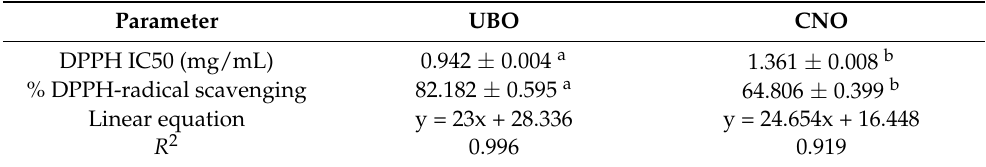
Table 6. Antioxidant activity of UBO and CNO, and correlation between TPC and AA in both oil samples.